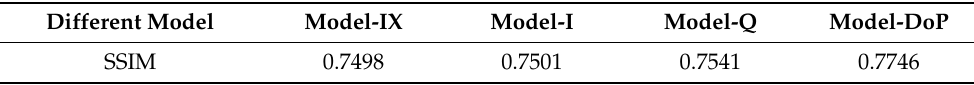
Table 4. The average SSIM for the reconstructed targets in Figure